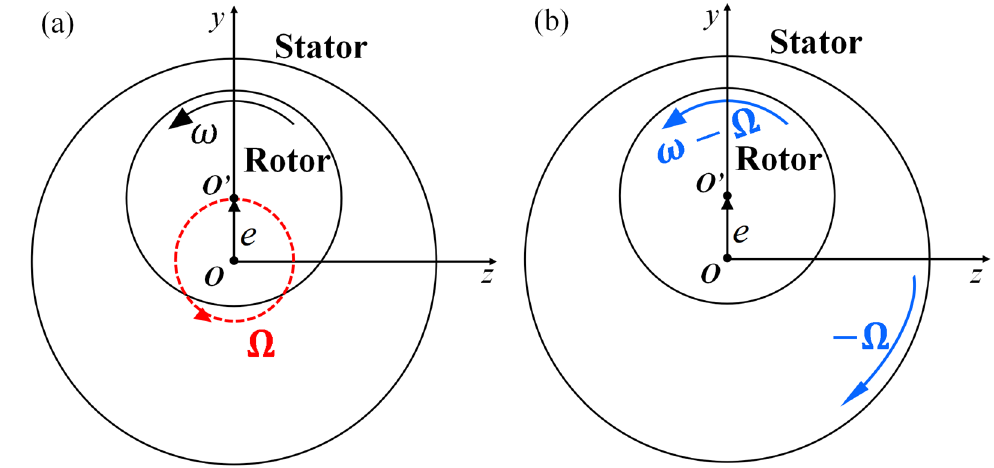
Figure 5. Schematic diagram of the quasi-steady-state model.